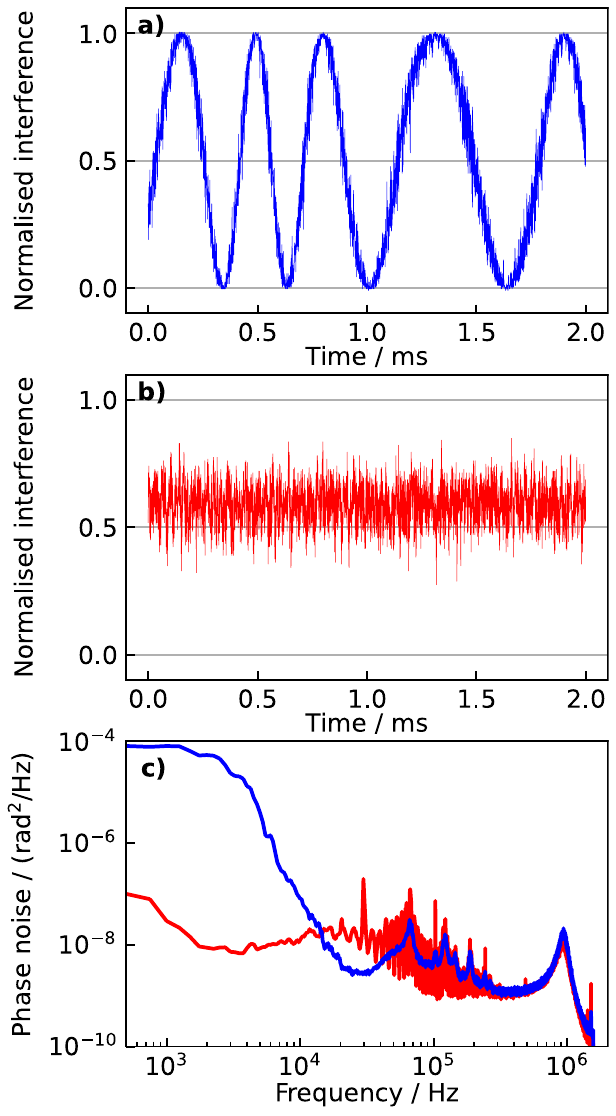
Fig. 3 QKD lasers interference with unstabilized and stabilized fi